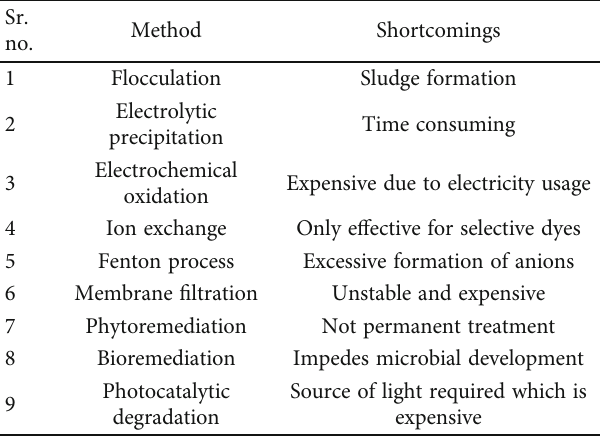
Table 3: Shortcomings of dye removal techniques.